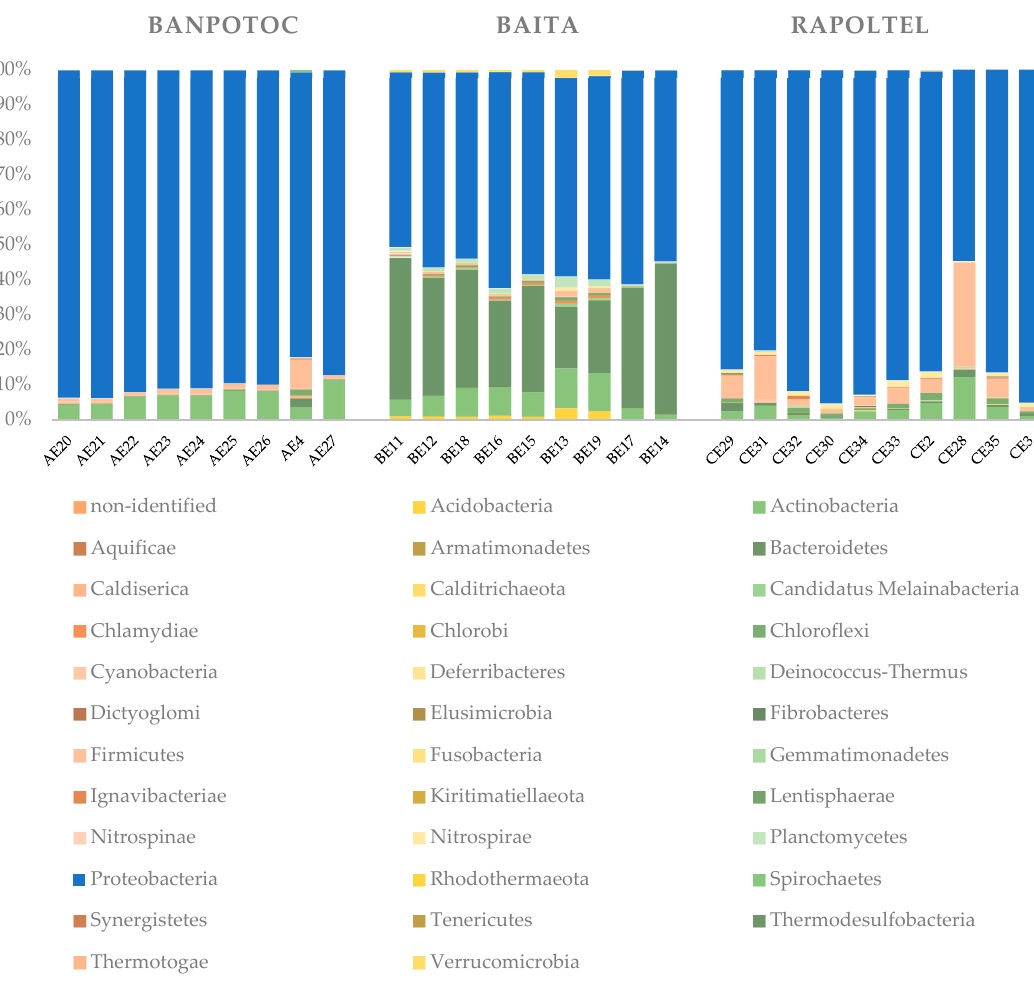
Figure 3. The relative abundance of the Bacteria phyla in the analyzed membranes, showing the dominant Proteobacteria in blue (see also Table S1).